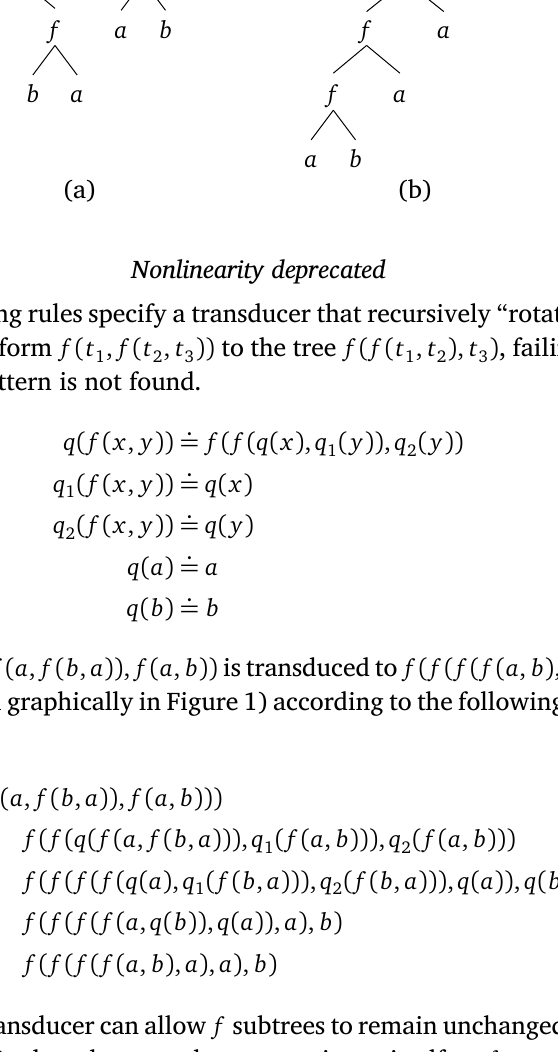
Figure 1: Local rotation computed by a nonlinear tree transducer. Trees (a) and (b) are in the tree relation of the transducer defined in Section